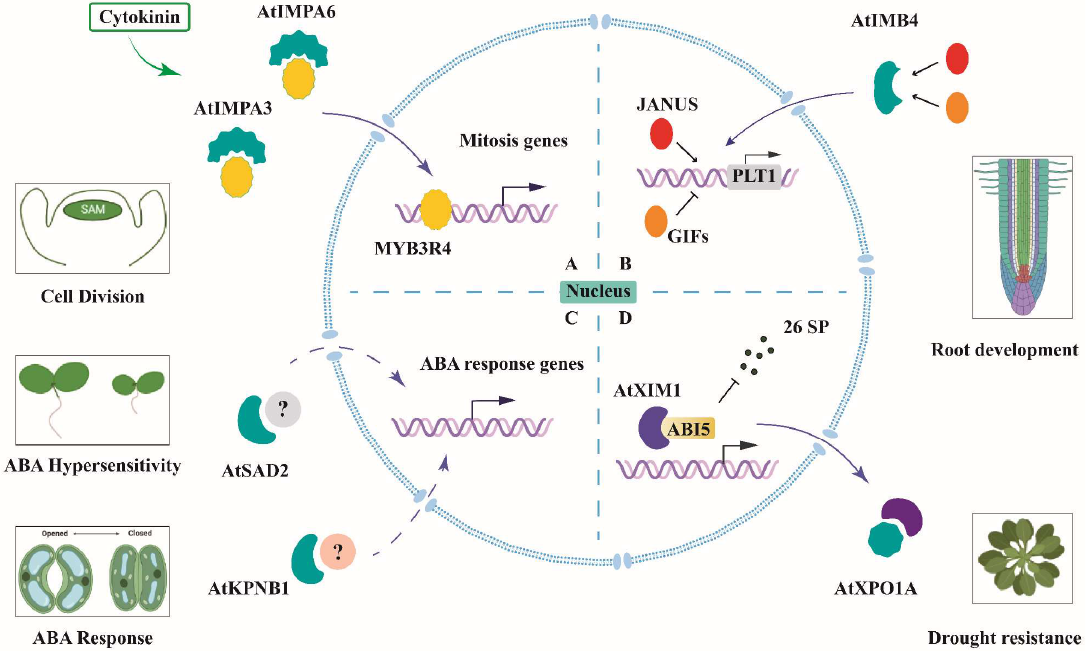
Figure 4. A schematic illustration of Arabidopsis KAP-mediated nucleo-cytoplasmic transport in hormone signaling for plant development. ( A ) Cytokinin regulates cell division by promoting nuclear shuttling of transcription factor MYB3R4, mediated by AtIMPA3 and AtIMPA6, in the shoot apical meristem (SAM). ( B ) AtIMB4 mediates the nuclear partitioning of GRF-INTERACTING FACTOR1 (GIF1)/ANGUSTIFOLIA3 and JANUS, which antagonistically regulate PLETHORA1 (PLT1) transcription. ( C ) AtSAD2 and AtKPNB1 act as negative regulators in abscisic acid (ABA) signaling. The atsad2 mutant displays an ABA hypersensitivity response during seed germination and seedling growth. AtKPNB1 is involved in controlling ABA-induced stomatal closure under drought conditions. ( D ) AtXPO1A mediates the nuclear export of a WD40 repeat-containing protein, XIW1 (XPO1-interacting WD40 protein 1), which maintains the stability of ABA INSENSITIVE 5 (ABI5) in the nucleus. The schematic illustration was drawn with BIORENDER (https://biorender.com/ (accessed on 4 October 2022)).